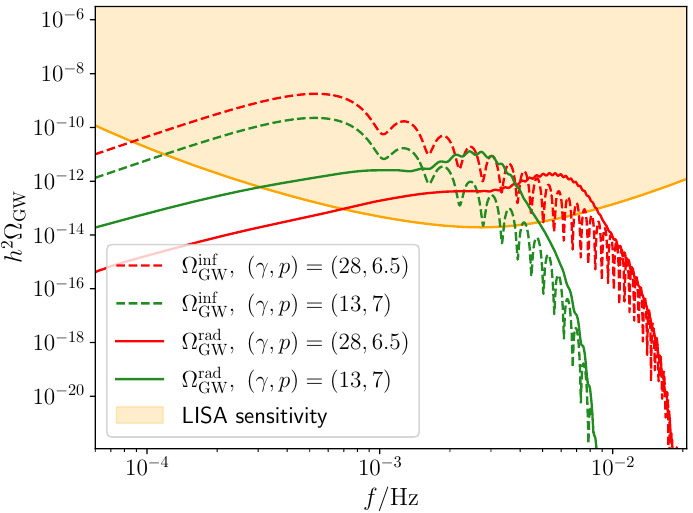
Figure 10 . Ω rad and Ω inf corresponding to the points in parameter space highlighted with crosses GW GW in figure 9. For illustrative purpose we choose the same time of the feature N out = 28 . 5 for both scenarios. The position of the peak of Ω inf is then fixed — see eq. (4.50) — and larger γ implies GW a higher and wider signal. Conversely, increasing γ shifts the peak of Ω rad to higher frequencies, GW while its overall amplitude depends only on p , i.e. the enhancement of the power spectrum of the curvature